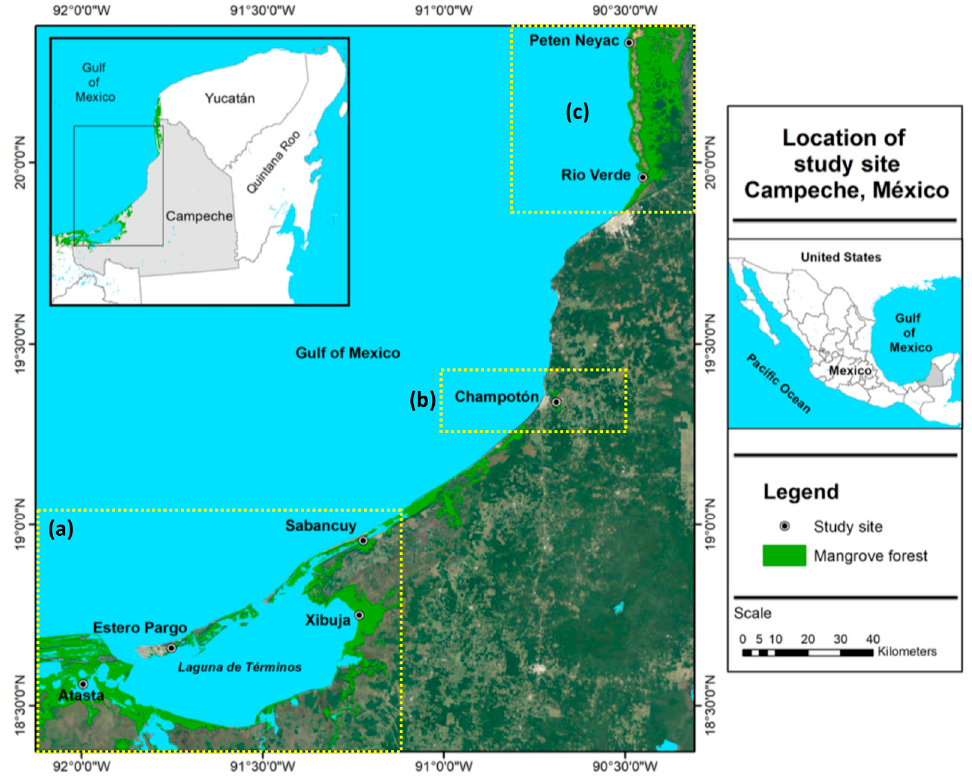
Figure 1. Map of the seven study mangrove forests bordering the coast of Campeche, México. ( a ) Laguna de Terminos, ( b ) Rio Champoton, and ( c ) Los Petenes Biosphere Reserve.